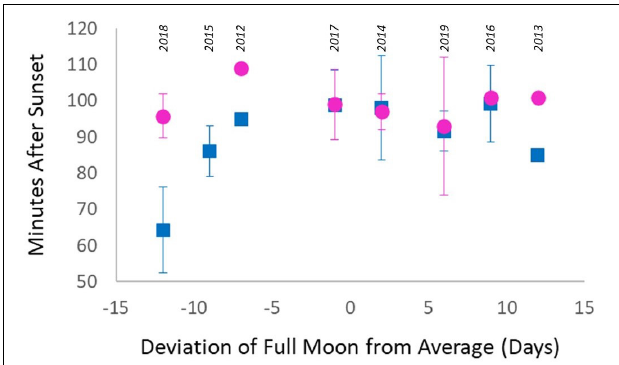
FIGURE 8 | Spawn time (minutes after sunset) of Dendrogyra cylindrus plotted against the relative date of the full moon in comparison with the 8-year average (2012–2019). Pink circles represent average female spawn times, blue squares are average male spawn times, and error bars show standard deviations. The datapoint for male spawn time in 2013 indicates the earliest confirmed observation, but many males had already spawned at an unknown interval before this. Spawn times between males and females closely align near the lunar average, but male spawn time is earlier as the full moon deviates from the